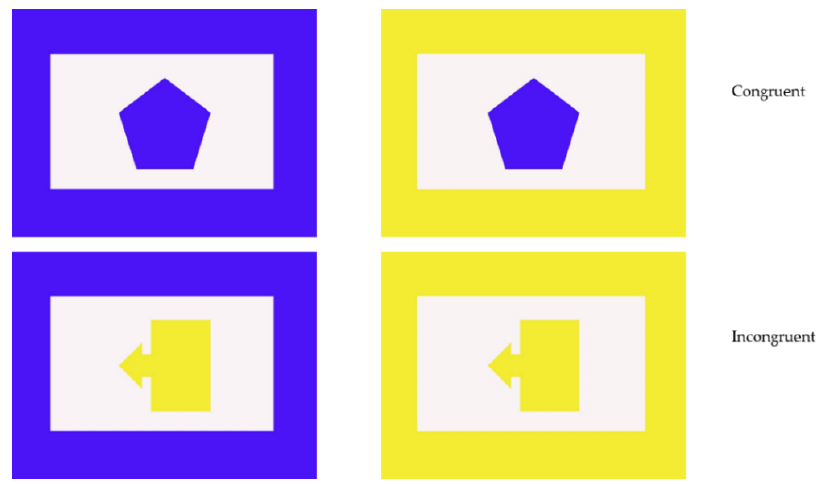
Figure 1. Example of Phase Two and control trials. Top row shows a congruent trial and bottom row shows an example incongruent trial. The blue border was always correct.